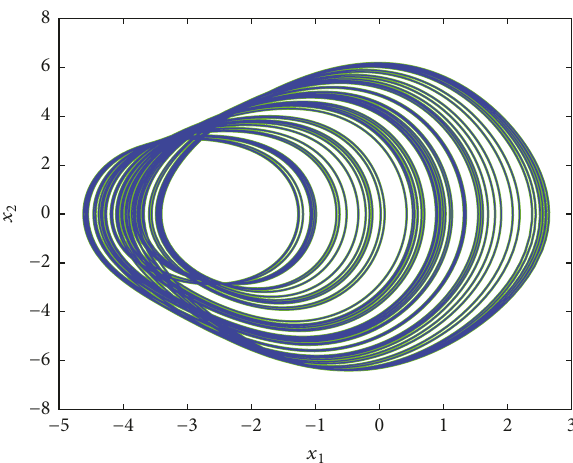
Figure 8: Phase portrait of the time delayed autonomous HPS.